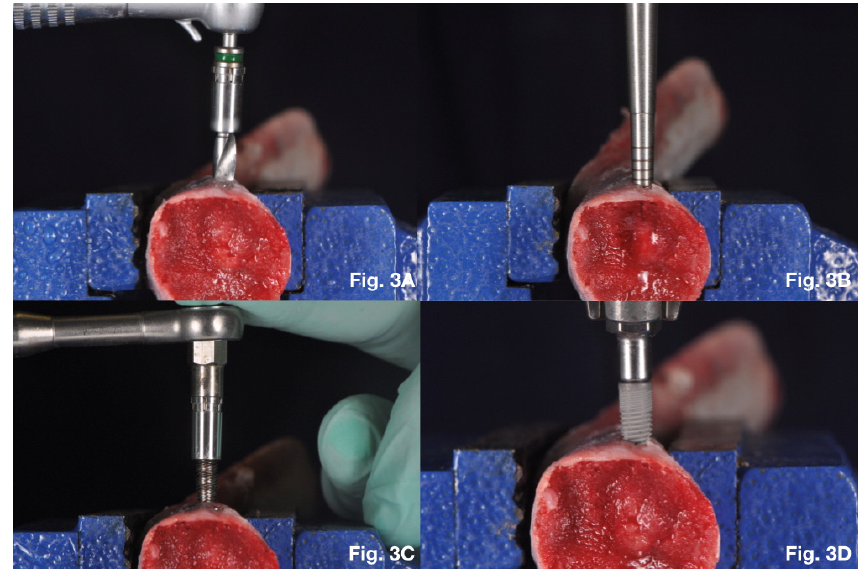
Figure 3. ( A ) Twist drills implant site preparation; ( B ) Summers osteotomes implant site preparation; ( C ) Bone compactors implant site preparation; ( D ) Implant placement using MGT-12 digital torque gauge.